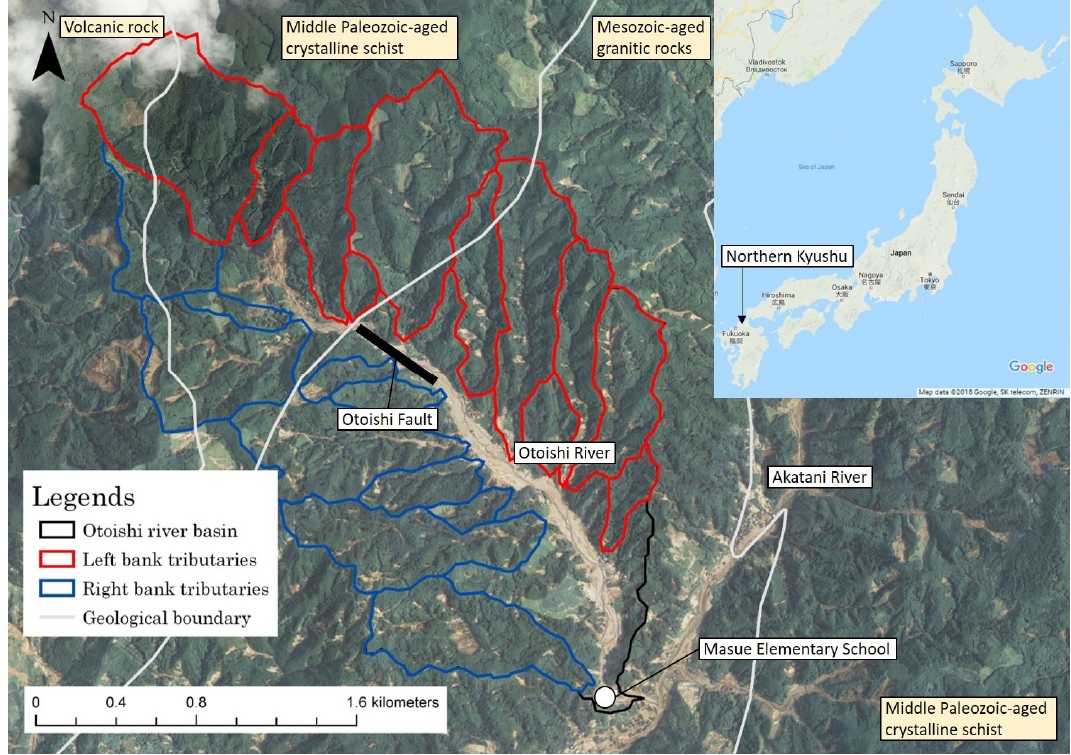
Figure 1. Map of the Otoishi River basin (the background picture is an aerial photograph taken after the disaster, released by the Geospatial Information Authority of Japan).